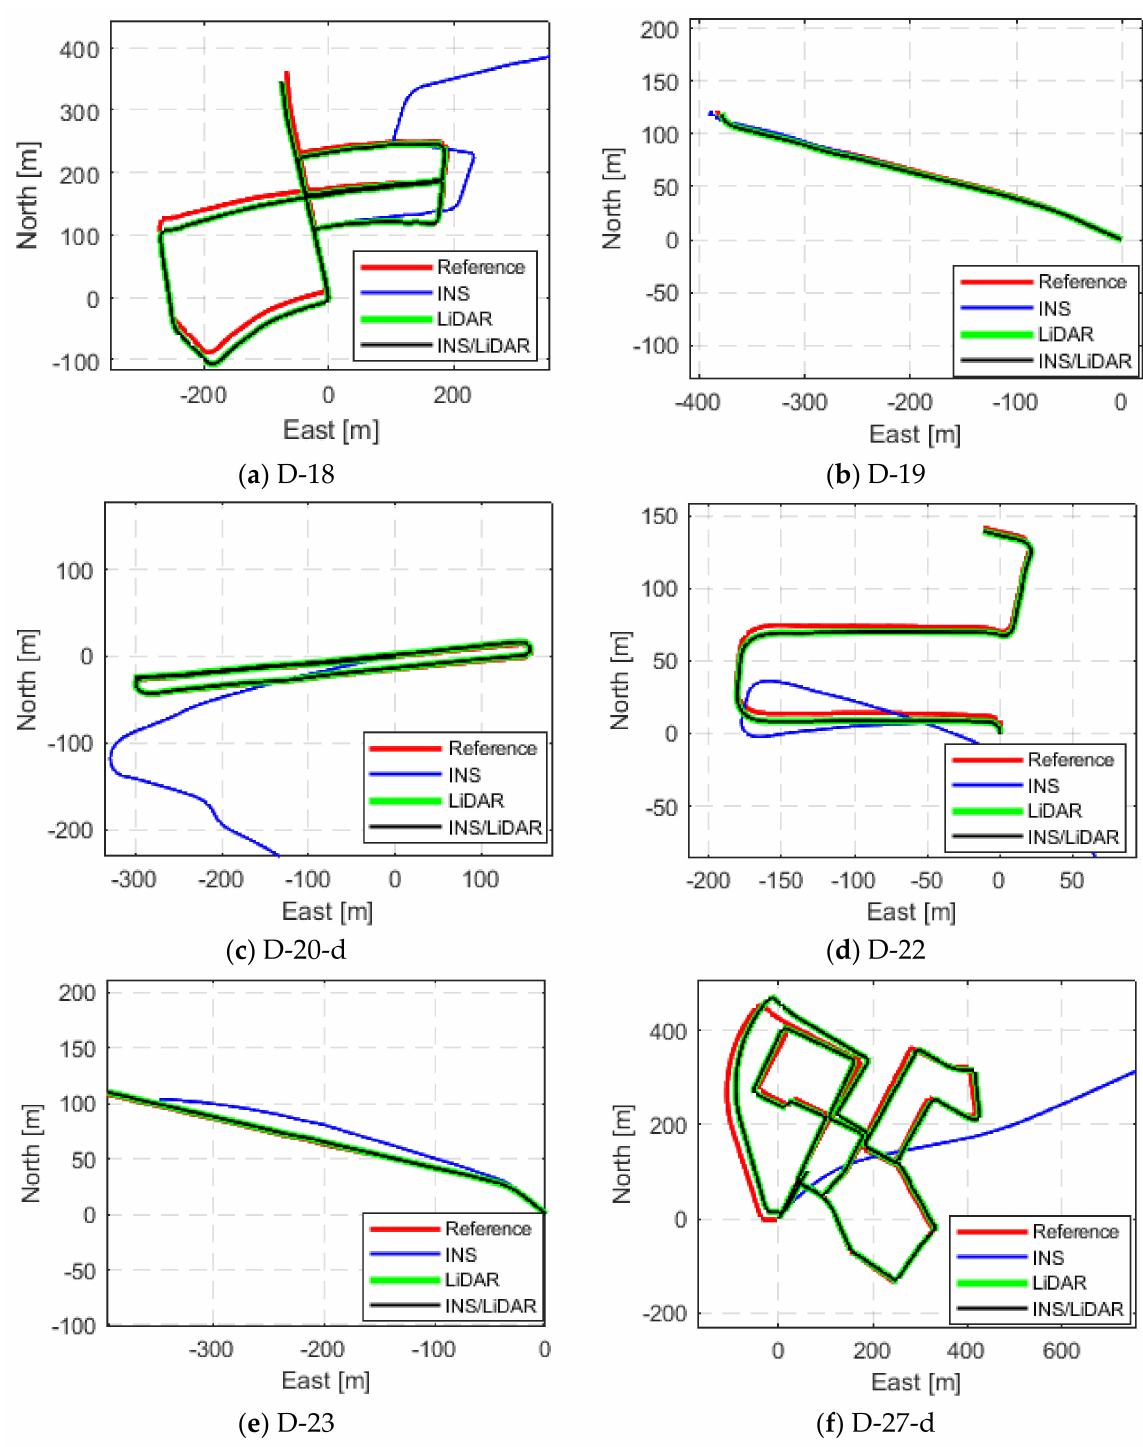
Figure 9. Complete GNNS signal outage: comparison of trajectories (D-18 to